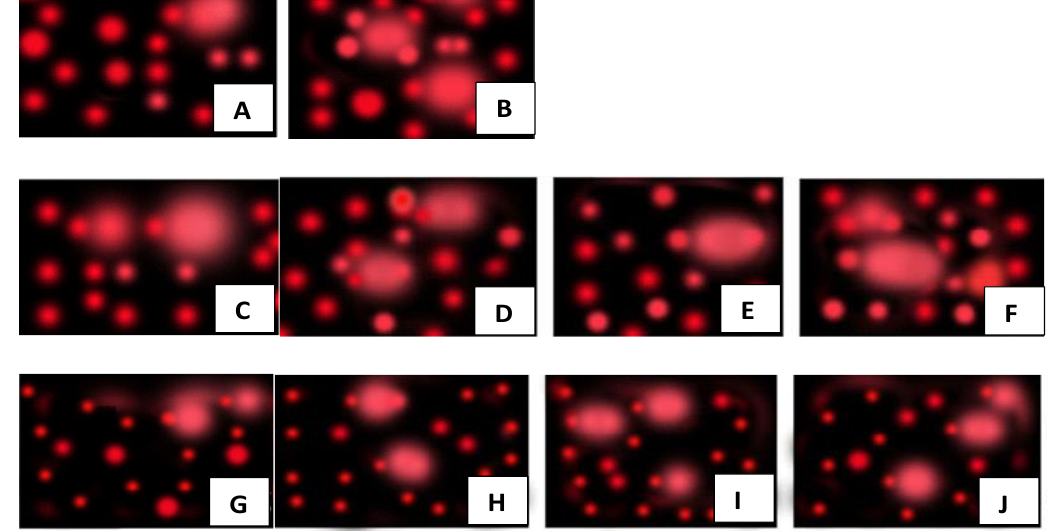
Figure 10. Photomicrographs of EtBr-stained DNA from protoplasts of P. granatum treated with nHAPs: ( A ) control; ( B ) NPK; ( C – F ) nHAP_PPE at concentrations of 50, 100, 500, and 1000 ppm, respectively; ( G – J ) nHAP_CE at concentrations of 50, 100, 500, and 1000 ppm, respectively.